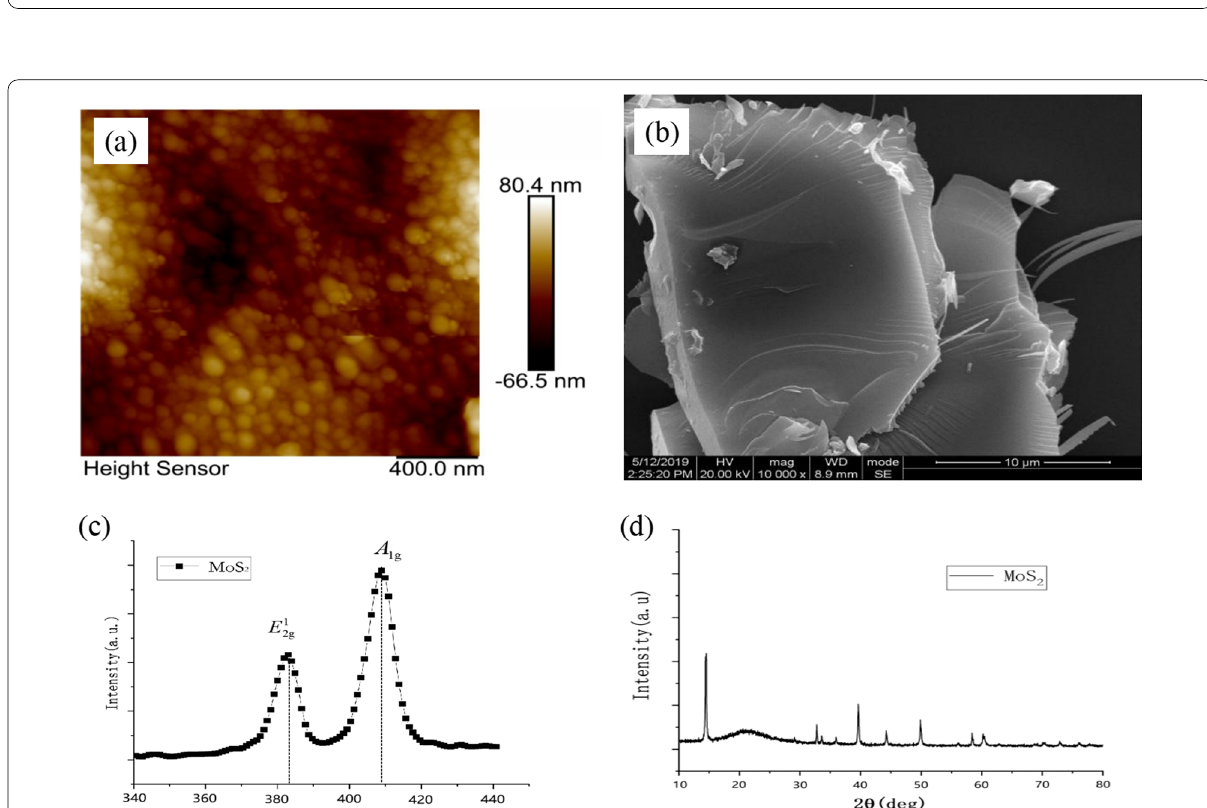
Fig. 3 Structure of MoS 2 nanosheets. a AFM image of MoS 2 nanosheets. b SEM image of MoS 2 nanosheets. c Raman spectra of MoS 2 nanosheets. d XRD image of MoS 2